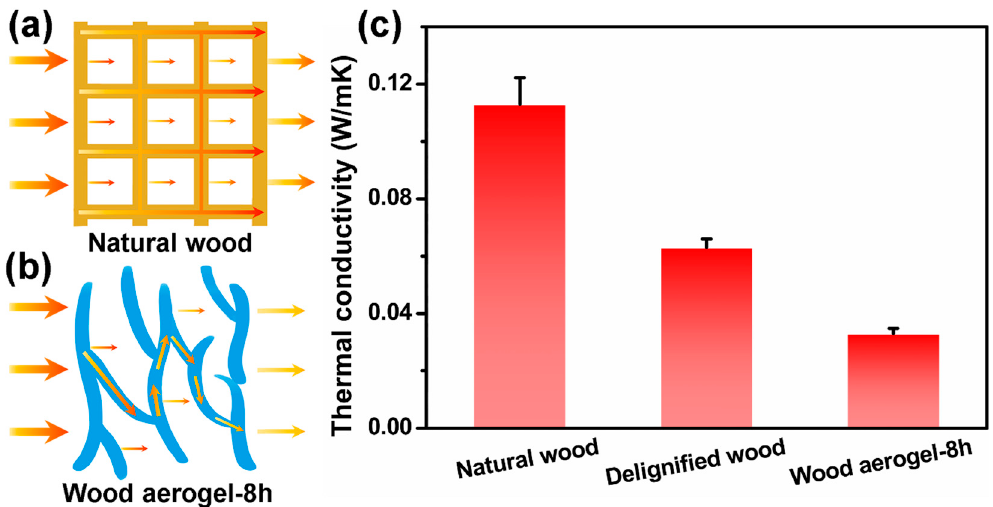
Figure 7. Thermal conductivity of wood specimens: ( a ) schematic of thermal conduction in natural wood; ( b ) schematic of thermal conduction in wood aerogel; ( c ) thermal conductivity of natural wood, delignified wood, and wood aerogel-8 h.